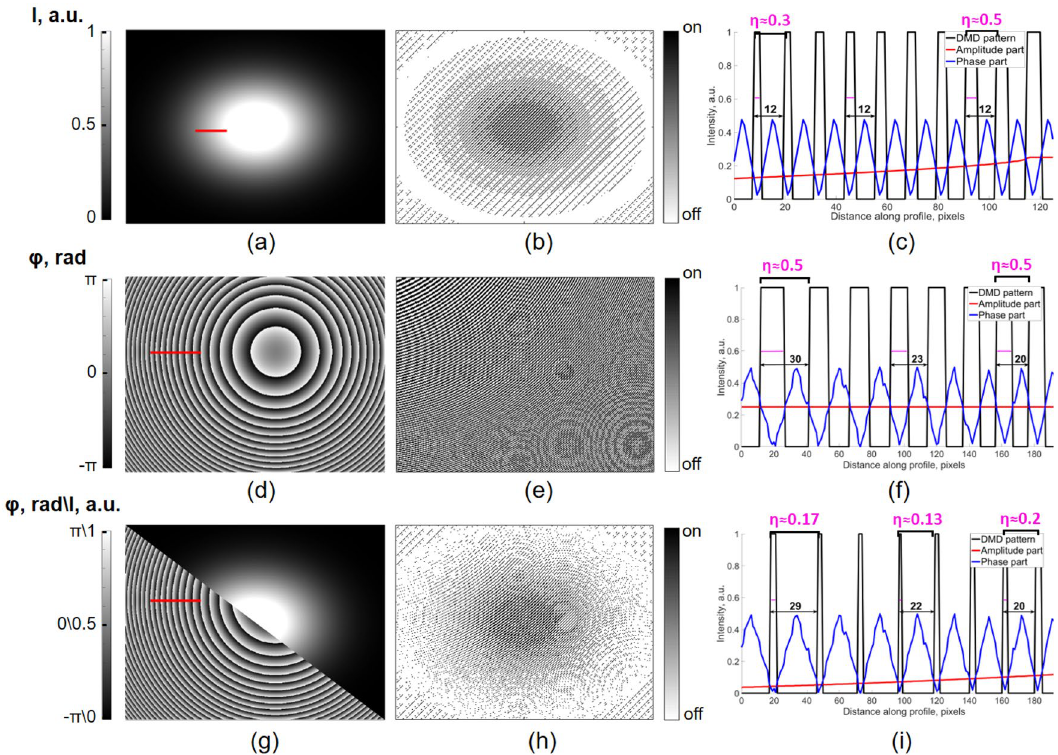
Figure 2. Demonstration of the independent modulation of the amplitude ( a – c ), phase ( d – f ), and amplitude- phase ( g – i ). The target amplitude ( a ), phase ( d ), and amplitude-phase ( g ) distributions are presented in the first column. The red line indicates the coordinates of the plot in ( c , f , i ); The resultant DMD patterns with carrier 2 π frequency 12 ( b , e , h ) are shown in the second column; ( c , f , i ) the plot of DMD pattern function (black line), phase part (blue line) and amplitude part (red line) are shown in the third